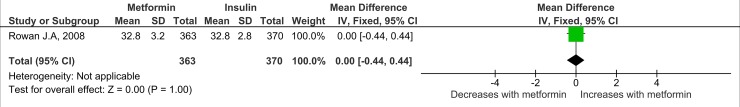
Neonatal abdominal circumference.Expressed as mean difference (fixed effects model) and 95% CI. IV, mean difference.